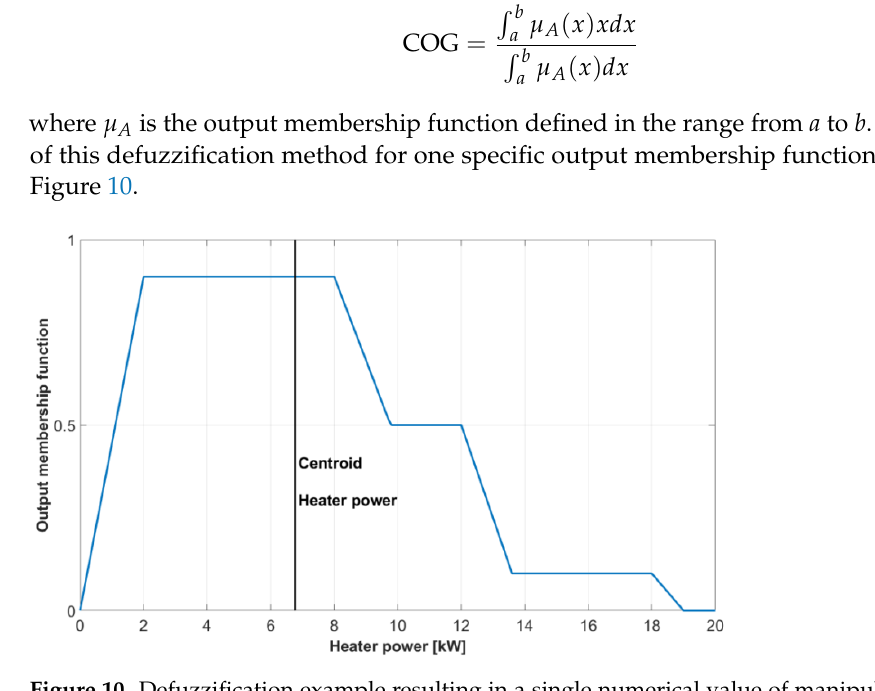
Figure 10 . Defuzzification example resulting in a single numerical value of manipulated variable (heater power).